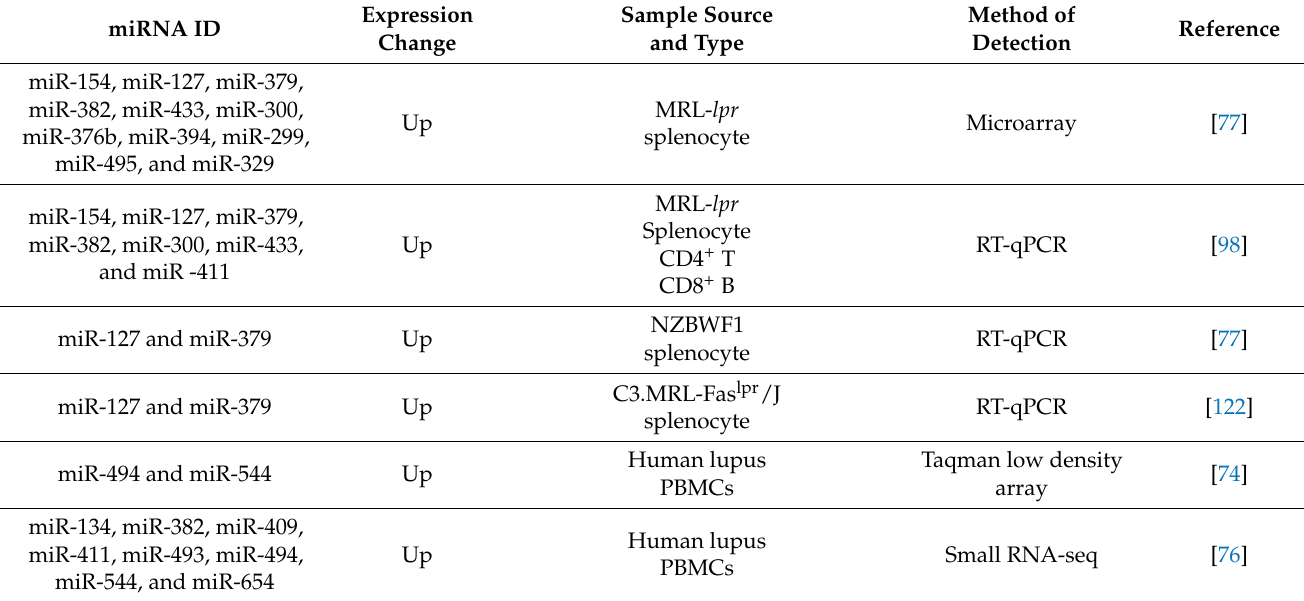
Table 1. Dysregulated miRNAs from the Dlk1-Dio3 locus in murine and human